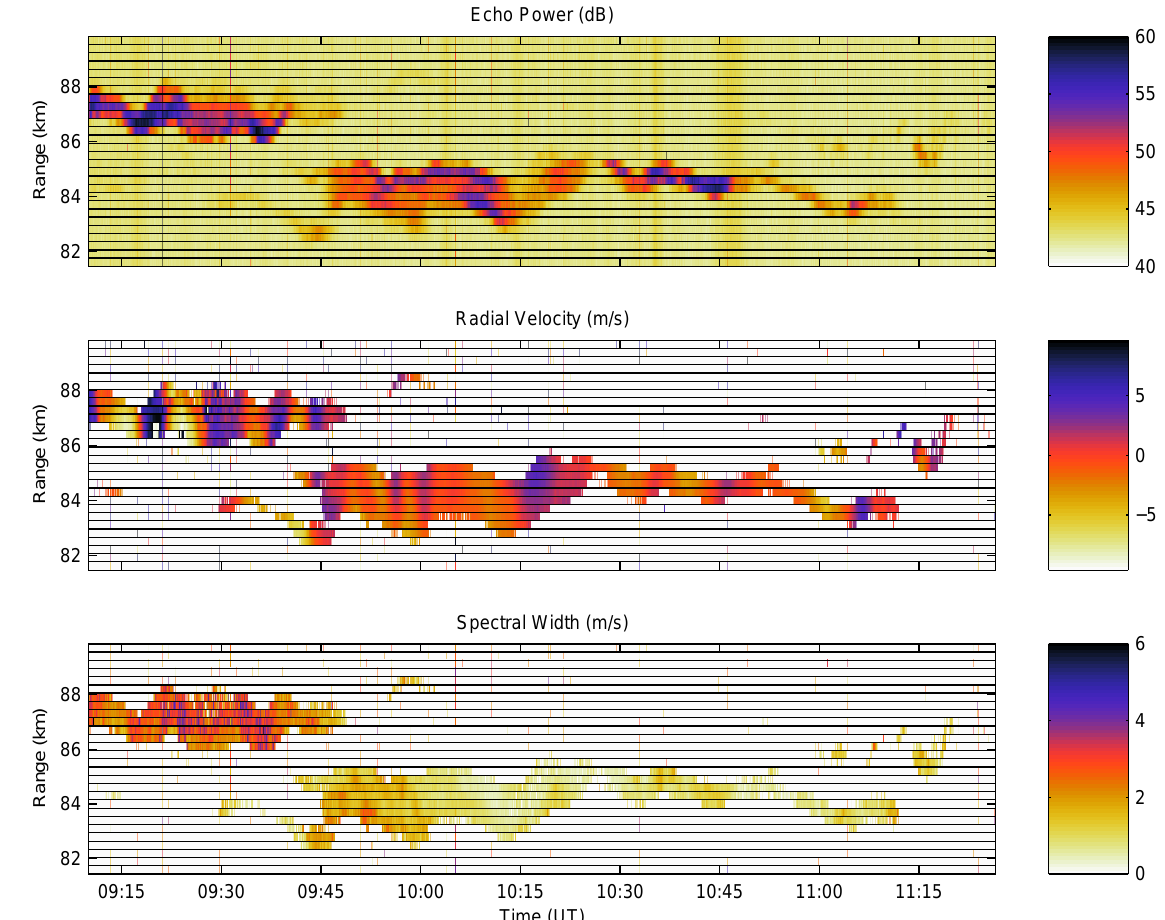
Fig. 8. Time histories of standard echo power, radial velocity, and spectral width from the observed PMSE on 30 July 2002. synthetic data. A population size of 100 individuals was randomly generated. Each individual is represented by five phase values ranging from 0 − 2 π with a 20-bit word.